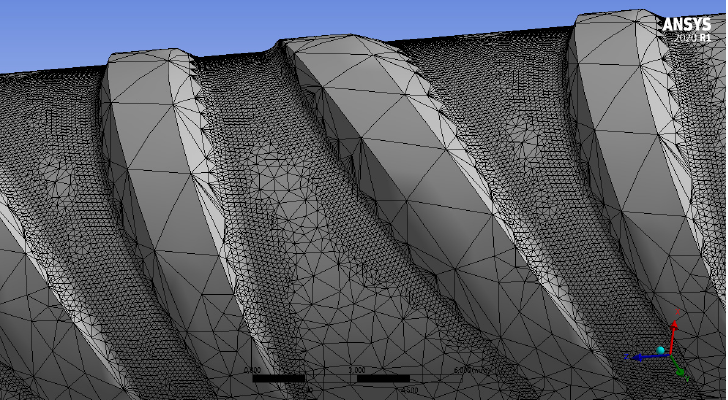
Figure 6. Final mesh of the alternated rib side of specimen with a diameter of 12 mm generated in AN-SYS 2020 R1 .